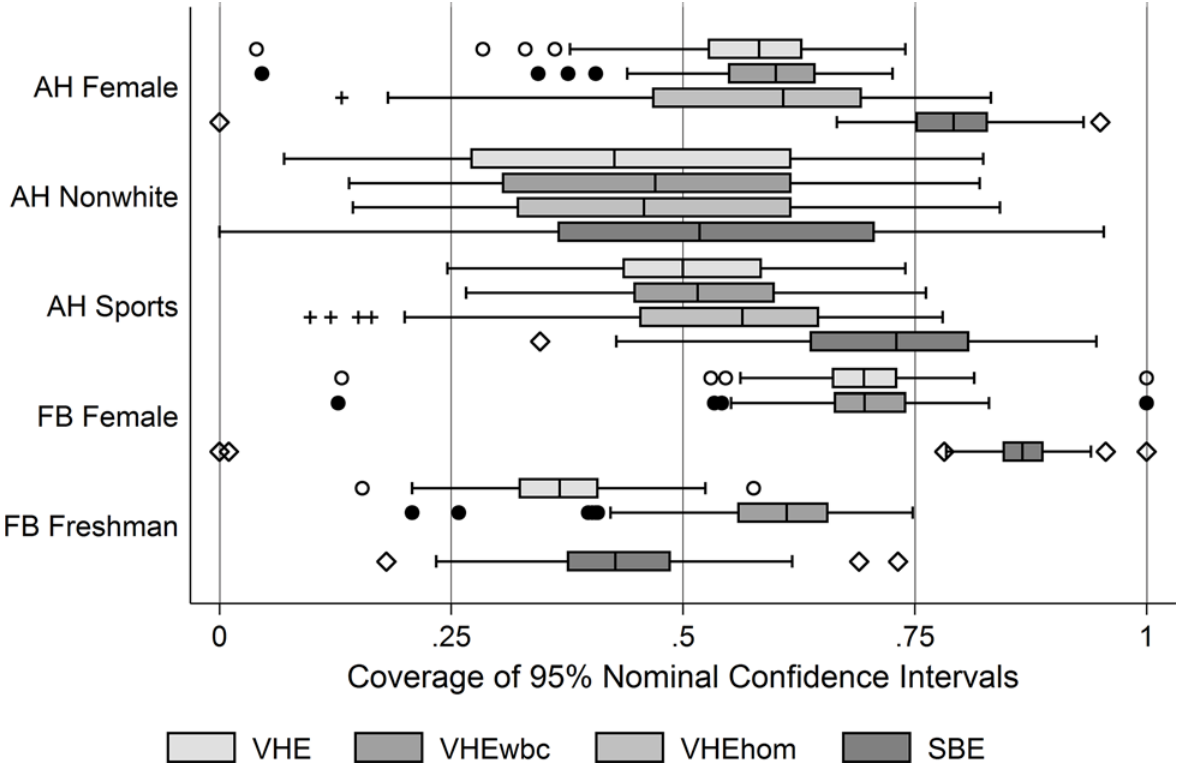
Fig 4. Distributions across networks for coverage rates based on the VHE, VHEwbc, VHEhom, and SBE estimators, by variable and data set. Note: The expected coverage rate across networks for SRS is .95. AH indicates Add Health data set; FB indicates Facebook 100 data set. VHE indicates the Volz- Heckathorn Estimator; VHEwbc indicates the VHE with Branching Correction; VHEhom is the VHE with Higher Order Markov assumptions; and SBE indicates the Salganik Heckathorn Estimator. The estimators are described in text.